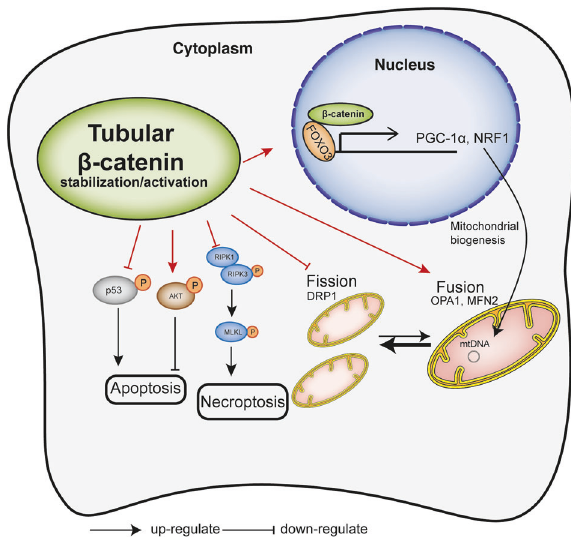
Fig. 9 Proposed mechanism of β -catenin regulating cell death and mitochondrial function in kidney tubule. Exposed to ischemia or LPS stress leads to kidney tubular mitochondrial dysfunction and cell death. As β -catenin stabilize in tubular cells, more active β -catenin translocates into the nucleus, enhances PGC-1 α transcrip- tion and activation through its binding and interacting with FOXO3 to form a transcription factor co-activator complex. Downstream gene NRF1 expression increase to active mitochondrial biogenesis. Mitochondrial dynamic remodels towards mitochondrial fusion than fi ssion. Consequently, mitochondrial mass and structure are preserved. In addition, β -catenin stabilization also ameliorates necroptosis via RIP3/MLKL pathway and apoptosis via AKT/ p53